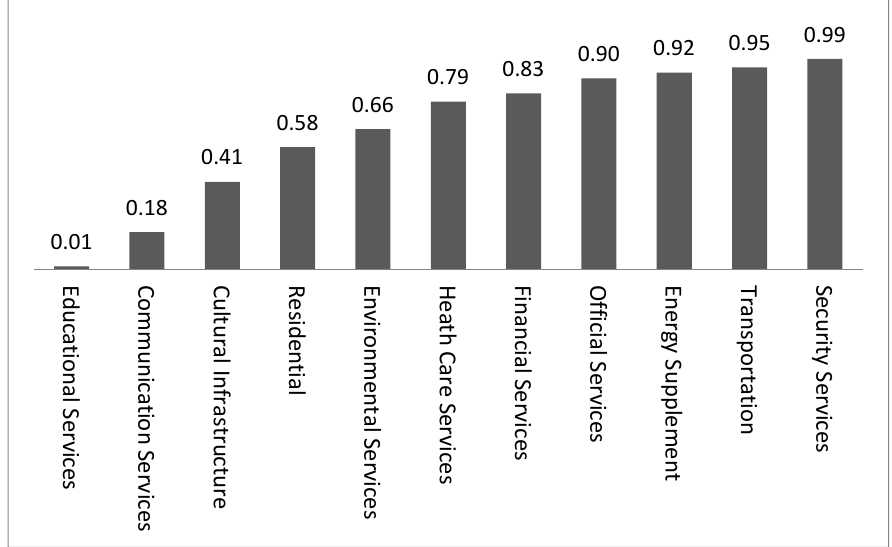
Fig. 2. The final results of ranking different